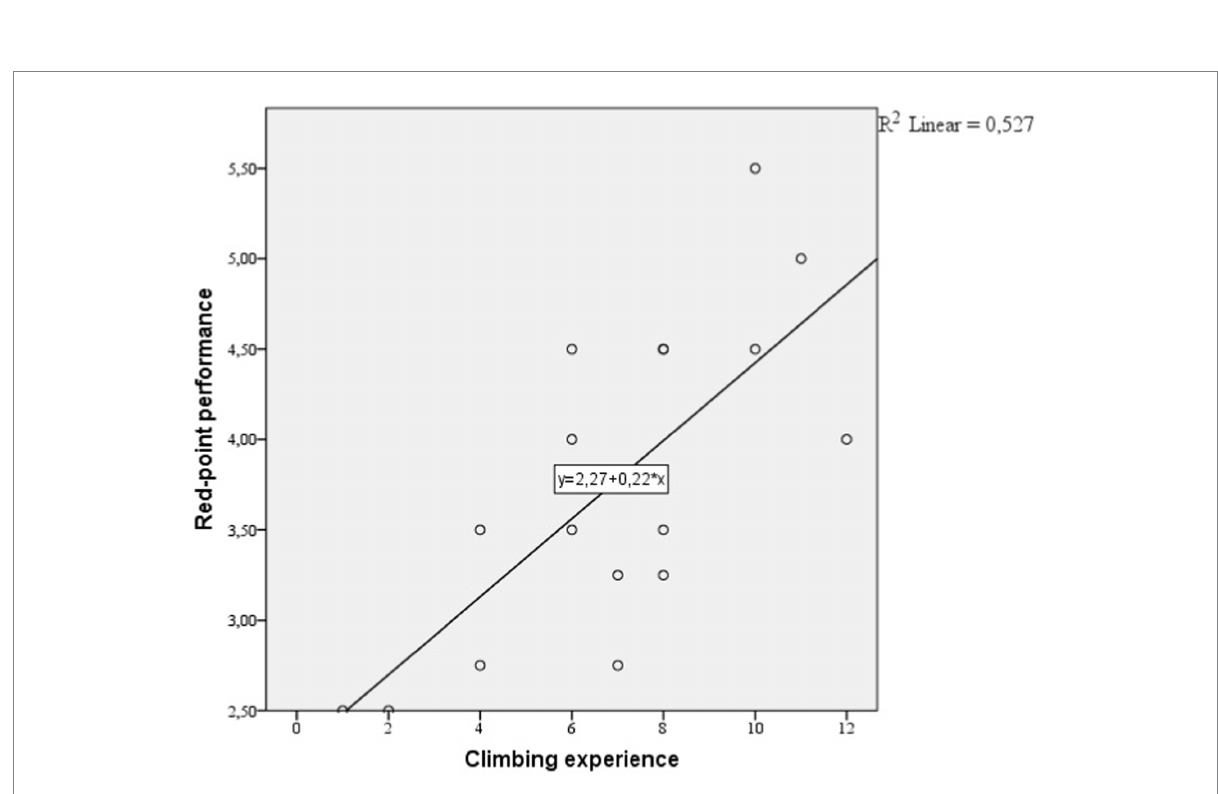
FIGURE 3 Linear regression between climbing experience and red-point